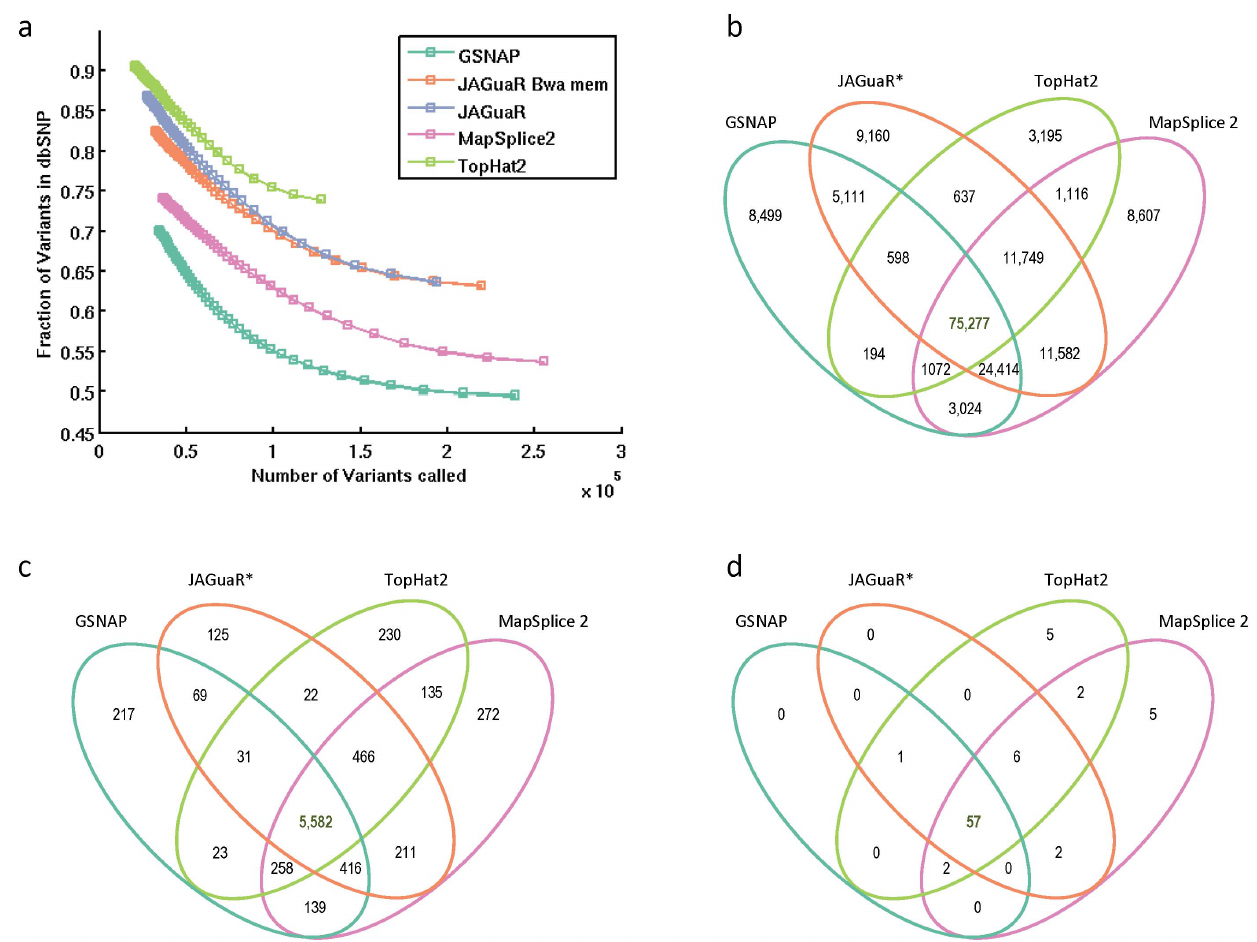
Figure 1. SNV concordance between tools for one read set (Sample 2). a) Number of variants in dbSNP (v137) plotted against number of variants called at various levels of depth. Depth begins on far right at 6 bp and each point represents increasing depth of 1 bp coverage. b) Overlap of known SNVs called c) Overlap of known non-synonymous SNVs called d) Overlap of SNVs called in COSMIC. All SNP calls were assessed at depth of 6.